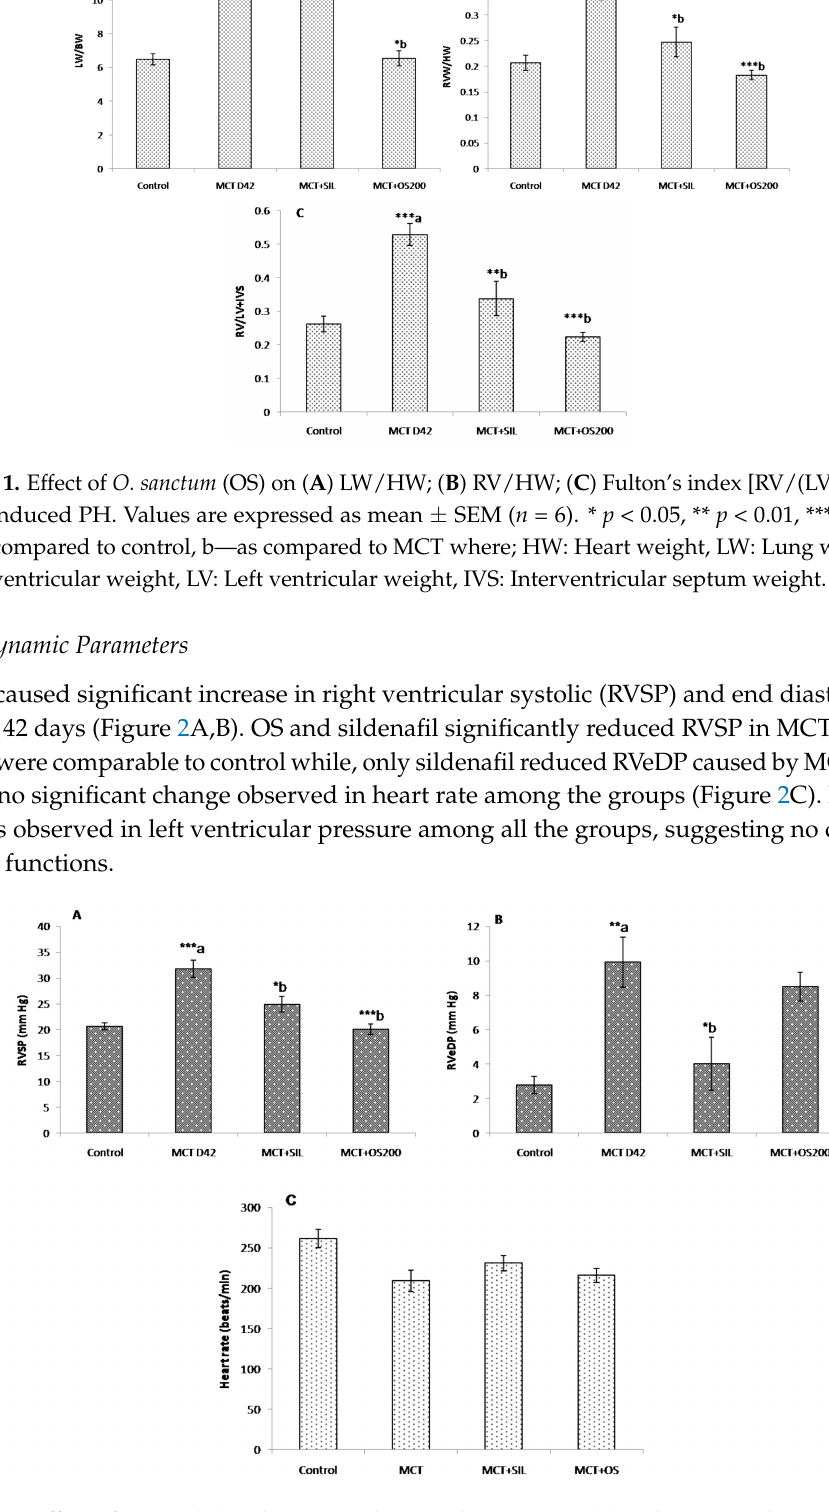
Figure 2. Effect of OS on ( A ) right ventricular systolic pressure; ( B ) right ventricular end diastolic pressure, and ( C ) heart rate in MCT-induced PH. Values are expressed as mean ± SEM ( n = 6). * p < 0.05, ** p < 0.01, *** p < 0.001; a—as compared to control, b—as compared to